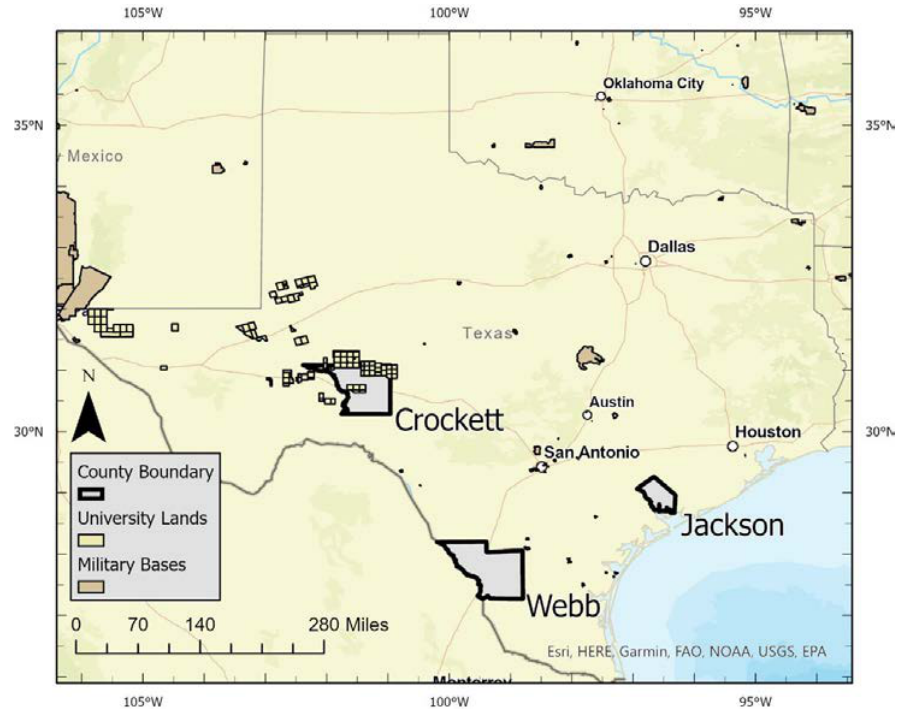
Figure 3. Location of the researched counties shaded in grey along with the potential users of geothermal resources, which are University of Texas land holdings, military bases, and major